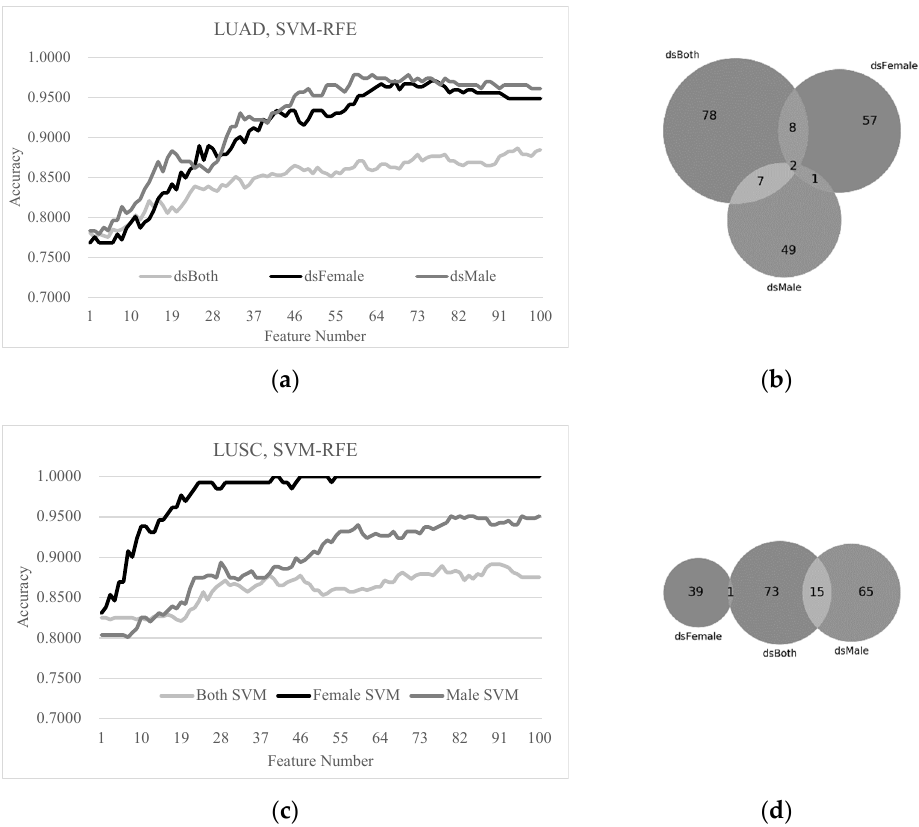
Figure 5. The SVM prediction performances and the sex disparities of the top-100 SVM-RFE-ranked biomarkers. ( a ) The prediction performances of the classifier SVM and ( b ) the Venn plot of the SVM-RFE-ranked biomarkers on the three models dsBoth, dsFemale and dsMale of the lung cancer subtype LUAD. ( c ) The prediction performances of the classifier SVM and ( d ) the Venn plot of the SVM-RFE-ranked biomarkers on the three models dsBoth, dsFemale and dsMale of the lung cancer subtype LUSC.